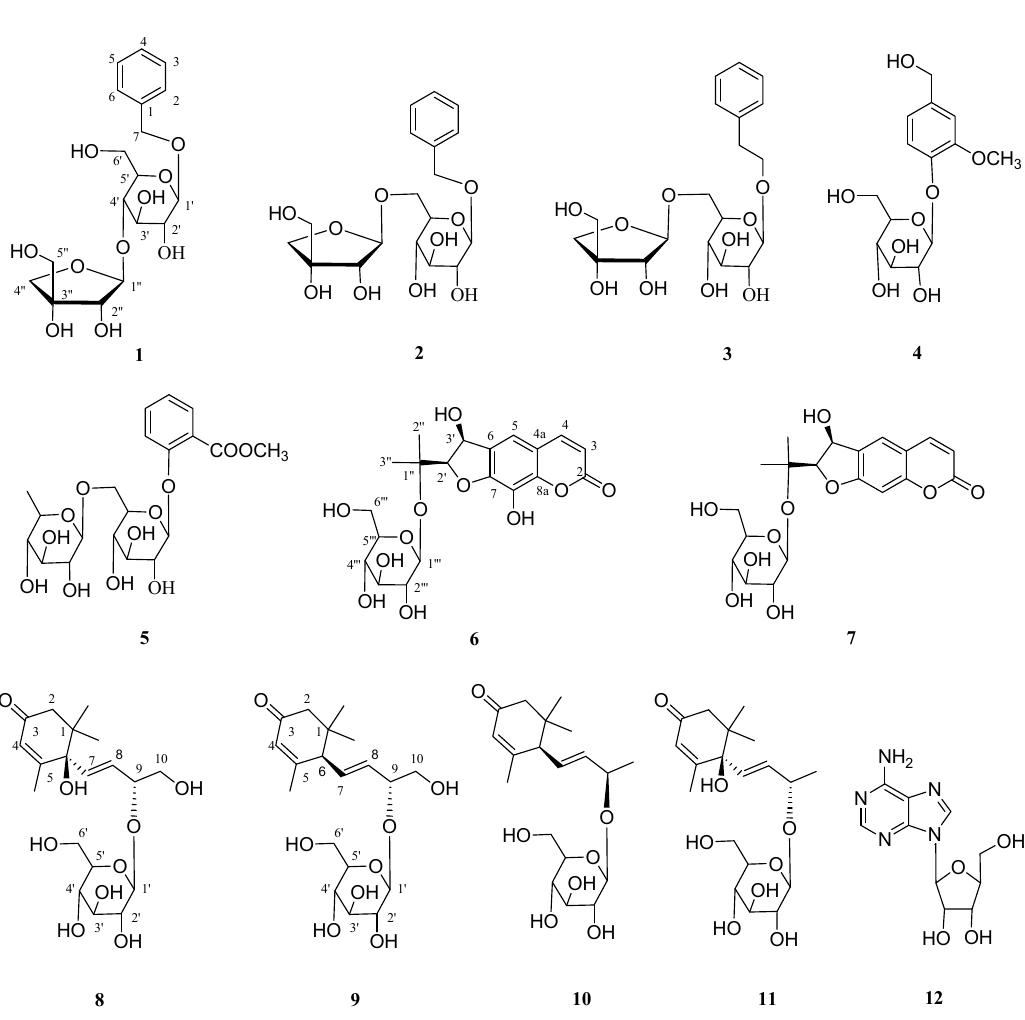
Figure 1. The chemical structures of compounds 1 – 12 from the stem and leaf of Clausena lansium.